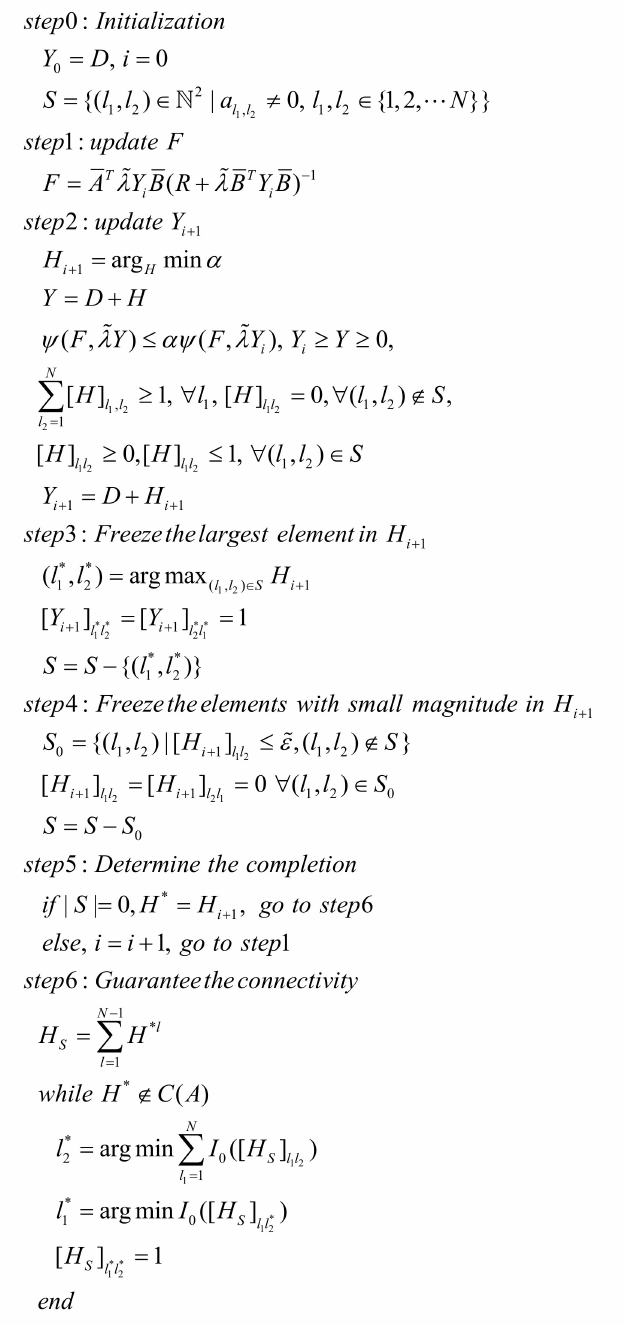
Figure 2. A greedy terminal cost matrix optimization